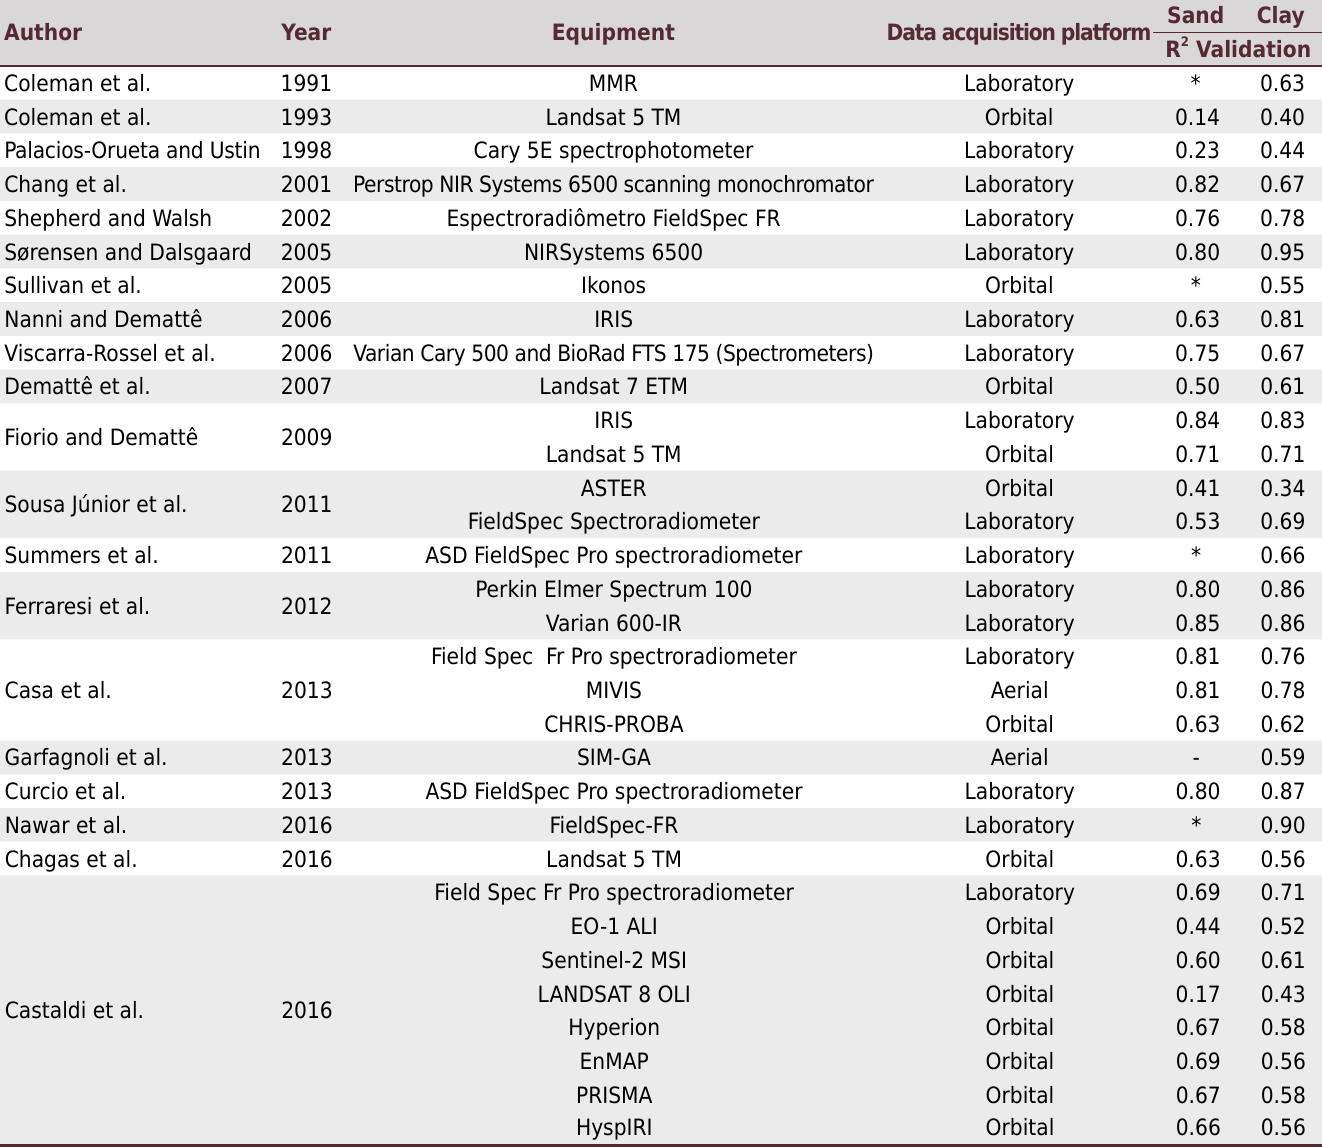
Table 4. R 2 values of validation of the sand and clay quantification models by multiple linear regression